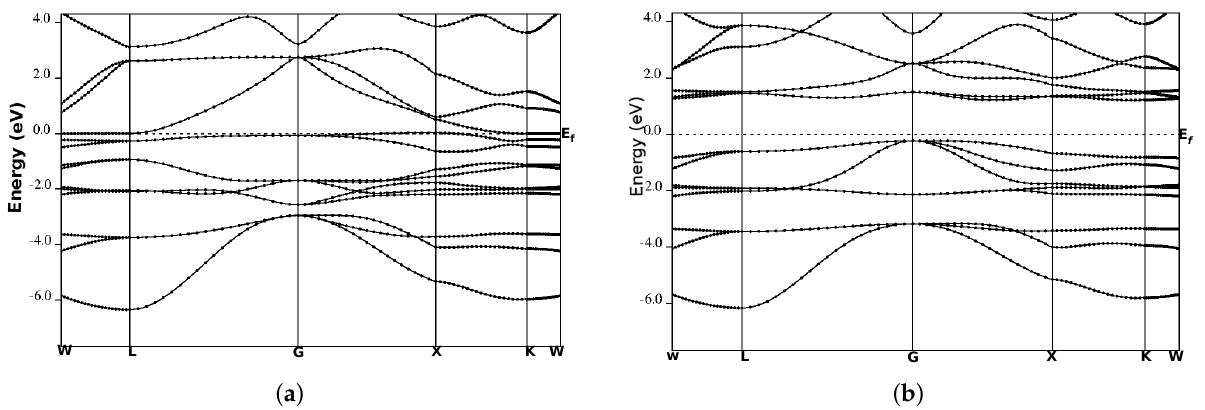
Figure 3. Band structures for CoCrSb ( a ) majority-spin and ( b ) minority-spin. The Fermi level is indicated by the dashed horizontal